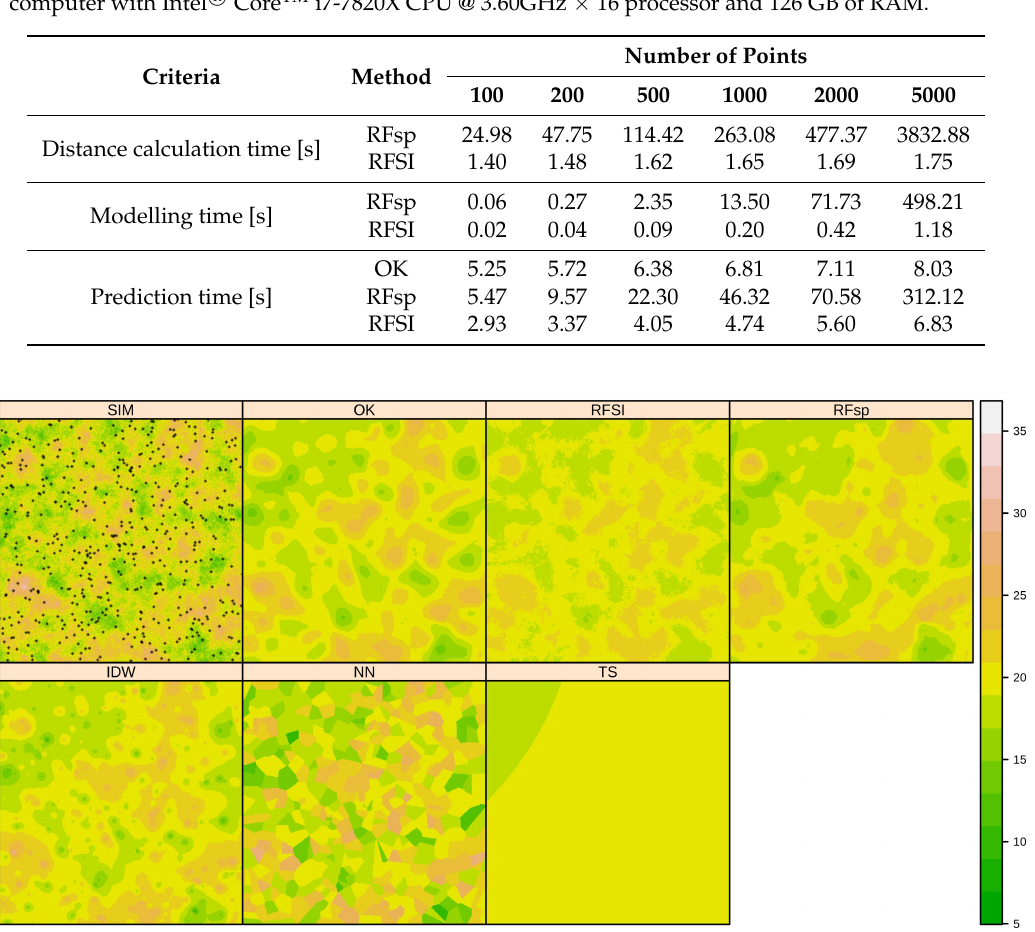
Table 1. Distance calculation time and modelling time for RFSI and RFsp, and prediction time for RFSI, RFsp and OK. All results refer to the synthetic case study and represent the average computing time computed from 100 simulations. All calculations and time estimations were done on a personal